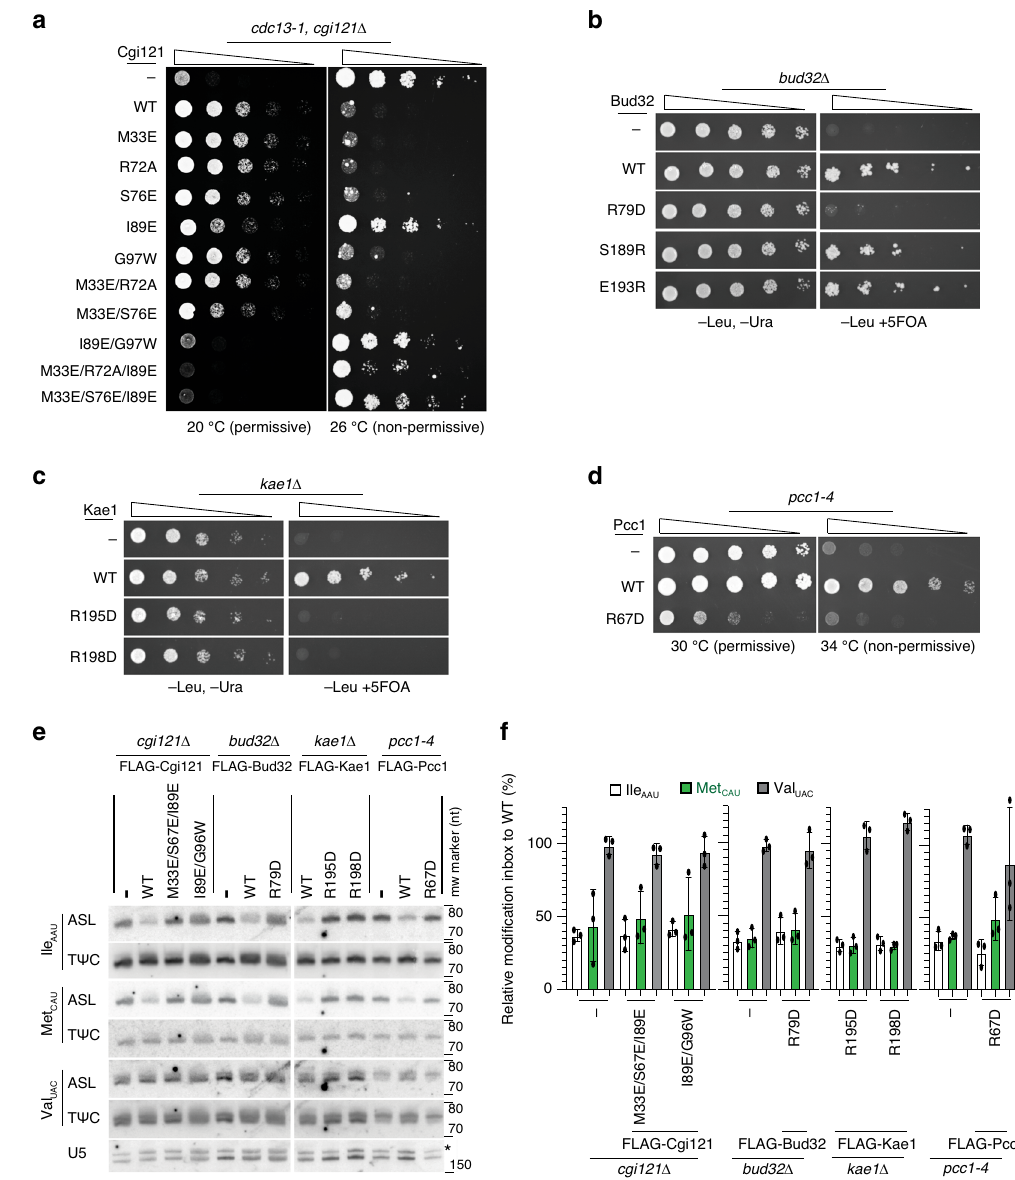
Fig. 6 The in vivo function of yeast KEOPS depends on the predicted tRNA-binding surfaces on all four core subunits. a Growth analysis of a cdc13-1 , cgi121 Δ yeast strain transformed with an expression plasmid encoding the wild type or indicated mutant sc Cgi121 fused to a 2XFLAG tag. Yeast transformed with the empty parental plasmid is included as a negative control. Cells were diluted to OD 600 = 1, subjected to fi ve-fold serial dilutions before plating and then grown for 4 days at 20 °C or 6 days at 26 °C. b Growth analysis of a bud32 Δ yeast strain transformed with an expression plasmid encoding the wild type or indicated mutant sc Bud32 fused to a FLAG tag. Yeast transformed with the empty parental plasmid is included as a negative control. The viability of the bud32 Δ yeast strain is maintained by a cover plasmid encoding untagged Bud32 WT with a URA3 selection marker. Cells were diluted to OD 600 = 1, subjected to fi ve-fold serial dilutions before plating on -leu, -ura or -leu, 5-FOA plates to counterselect for the cover plasmid. Plates were incubated for 4 days at 30 °C. c Growth analysis of a kae1 Δ yeast strain transformed with an expression plasmid encoding the wild type or indicated mutant sc Kae1 fused to a 2XFLAG tag. Yeast transformed with the empty parental plasmid is included as a negative control. The viability of the kae1 Δ yeast strain is maintained by a cover plasmid encoding untagged Kae1 WT with a URA3 selection marker. Cells were diluted to OD 600 = 1, subjected to fi ve-fold serial dilutions before plating on – leu, -ura or -leu, 5-FOA plates to counterselect for the cover plasmid. Plates were incubated for 4 days at 30 °C. d Growth analysis of a pcc1-4 thermosensitive yeast strain transformed with an expression plasmid encoding the wild type or indicated mutant sc Pcc1 fused to a FLAG tag. Yeast transformed with the empty parental plasmid is included as a negative control. Cells were diluted to OD 600 = 1, subjected to fi ve-fold serial dilutions before plating and then grown for 4 days at 30 °C (permissive) or at 34 °C (non-permissive). e , f Analysis of the in vivo levels of t 6 A. RNA was extracted from the cells used in panels ( a – d ) of this fi gure. e RNA was subjected to northern blot analysis using a complimentary probe targeting the anticodon stem loop (ASL) or the T loop (T Ψ C) of sc tRNA Met CAU , sc tRNA Ile AAU and sc tRNA Val CAC . mw- molecular weight, nt- nucleotide. f The relative modi fi cation index was quanti fi ed by the ASL/T Ψ C ratio of each protein variant compared to the same ratio of cells expressing WT protein. Hybridization of a probe complementary to the U5 snRNA (U5) was used as a loading control. Shown are representative blots and quanti fi cation averages (n = 3 experiments with biologically independent samples,